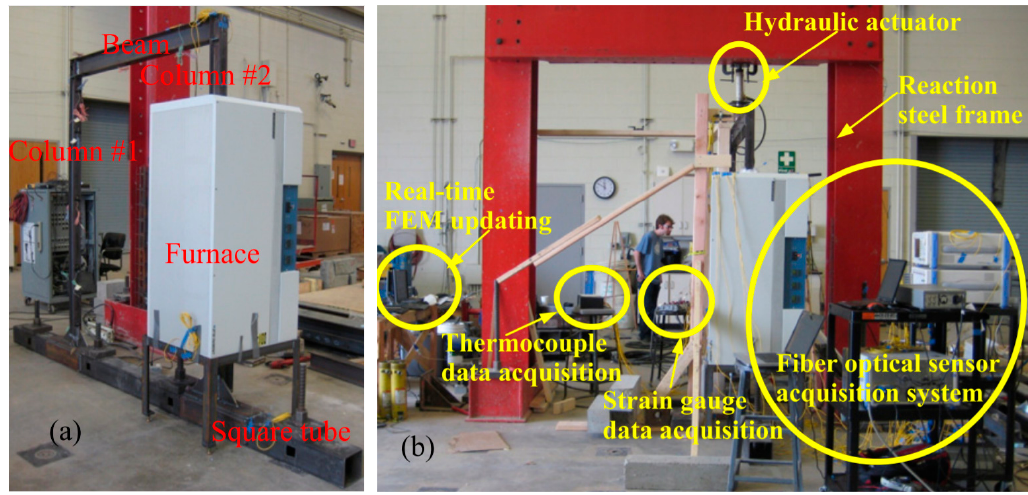
Figure 4. Application of long-period fiber gratings (LPFG) sensors in structural fire [56]: ( a ) Test set-up, and ( b ) instrumentation.